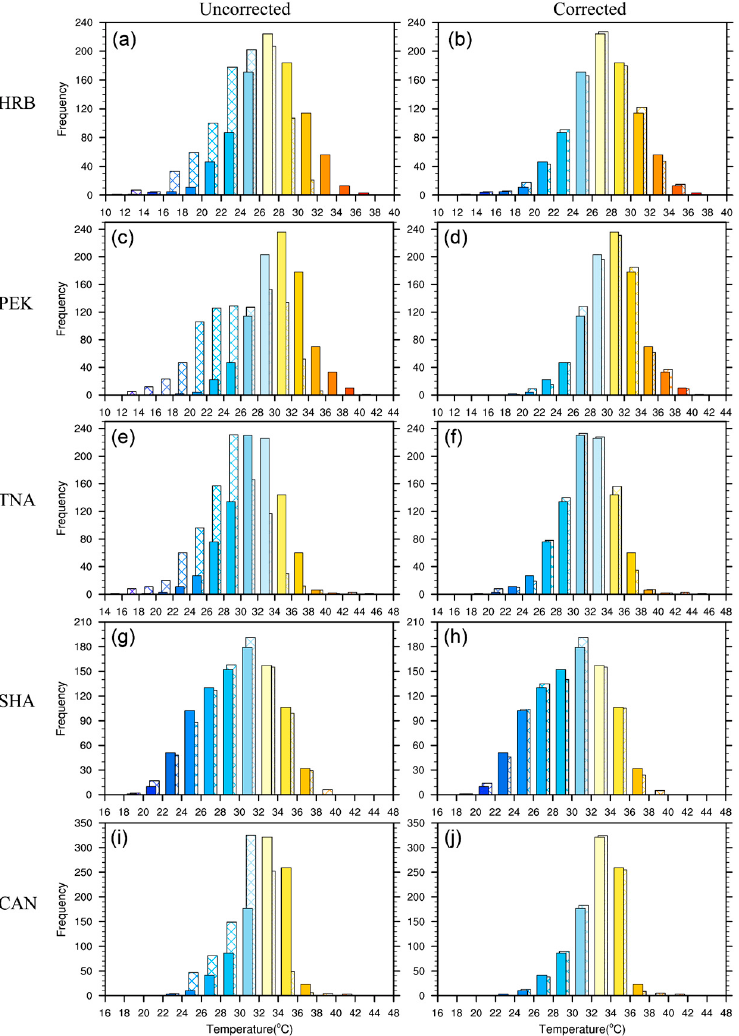
Figure 1. Distributions of summer daily maximum surface air temperature at the low-altitude aerodromes during 1991 − 2000: ( a , b ) HRB, ( c , d ) PEK, ( e , f ) TNA, ( g , h ) SHA, and ( i , j ) CAN, from observations (color shading column) and CESM1 simulations (criss-cross column). Different colors represent different temperature intervals. The temperature distribution goes to high value from blue to red. The left panel shows the comparison of observations and uncorrected CESM1 simulations. The right panel represents the same as the left panel but for the bias-corrected CESM1